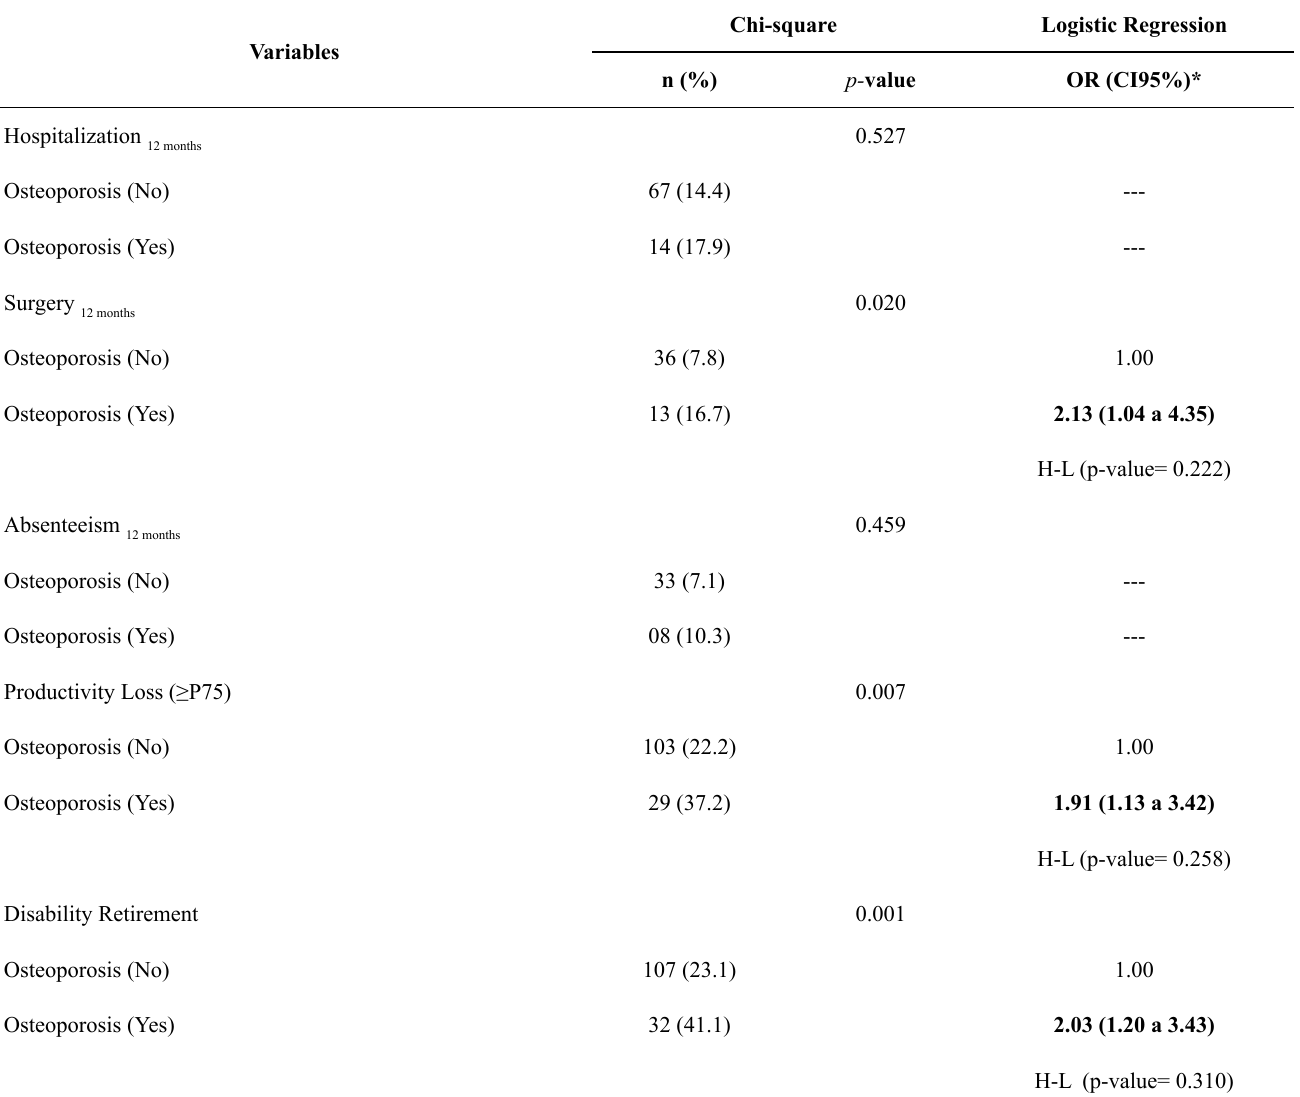
Table 2. Association between osteoporosis, use of hospital services and productivity loss in outpatients of the Brazilian National Health System (n= 78; Presidente Prudente, 2013).